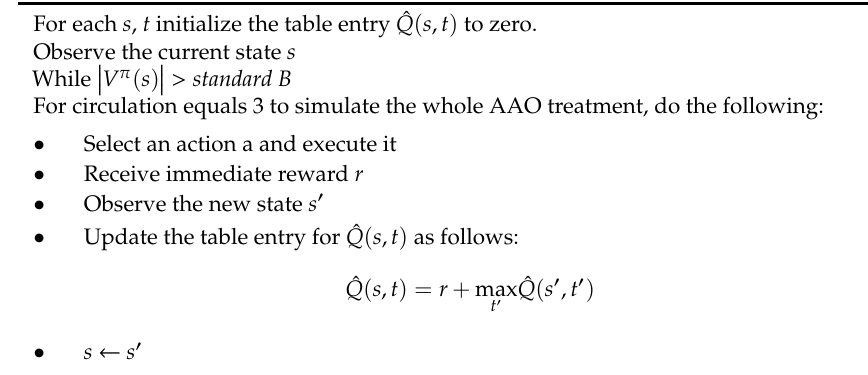
Table 3. Pseudo-code of the QL algorithm for the HRTs in the AAO system. For each s , t initialize the table entry ˆ Q ( s , t ) to zero.